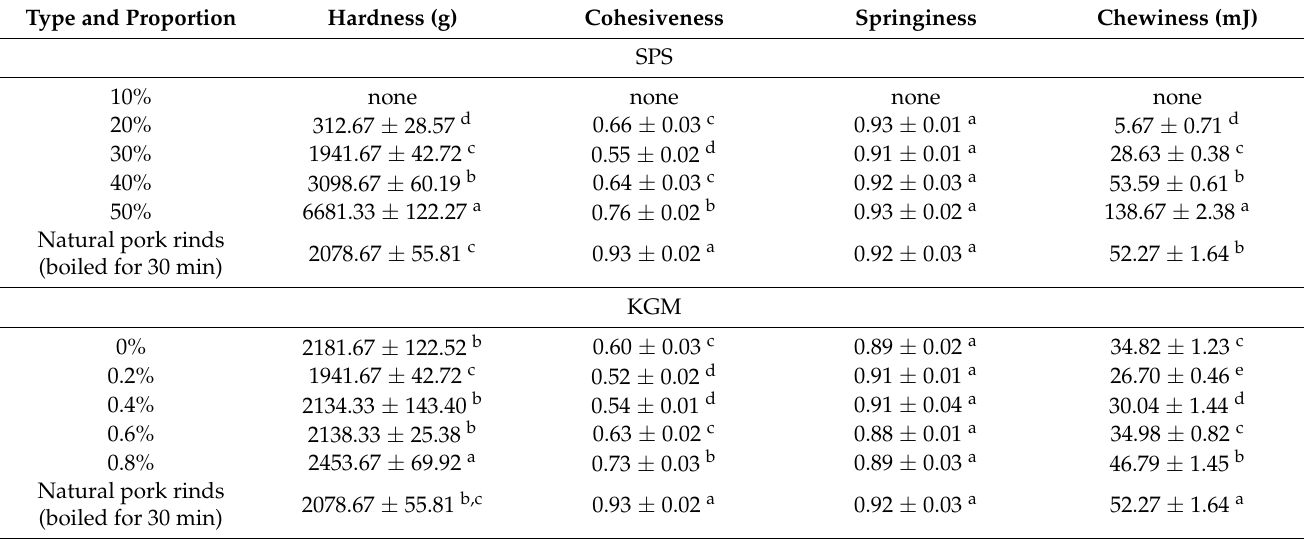
Table 1. The Texture profile analysis (TPA) of the plant-based pork rinds containing different SPS and KGM